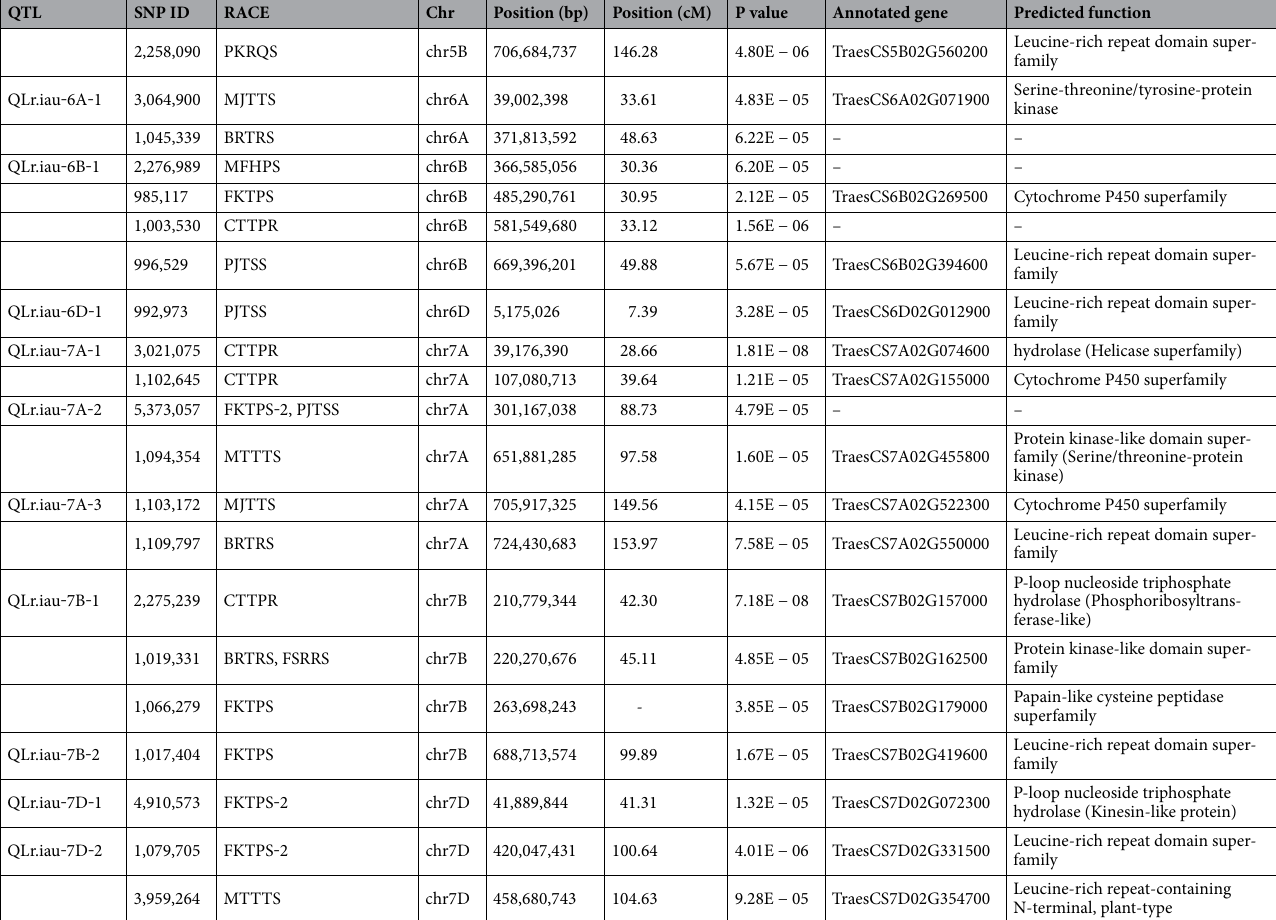
Table 3. Summary of the seedling leaf rust resistance quantitative trait loci identified against 10 Puccinia triticina races in the panel of 185 wheat